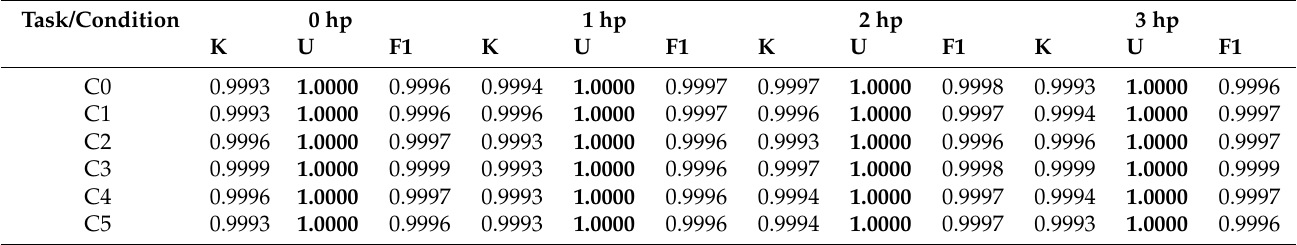
Table 6. Experimental results of the CRWU dataset.